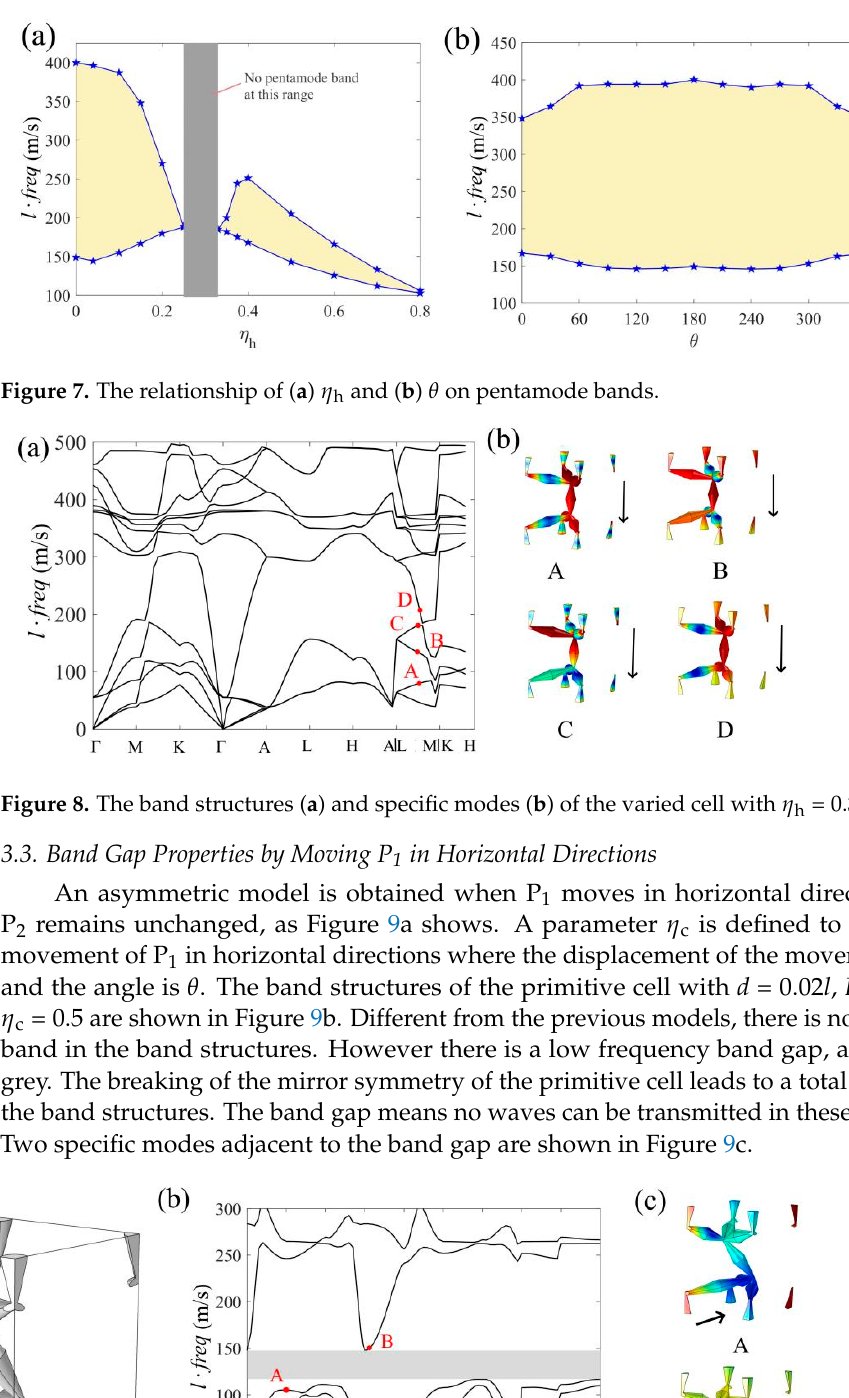
Figure 10. The effects of parameters ( a ) η c ( b ) θ on the band gaps of the primitive cell by moving P 1 in horizontal directions. 3.4. Band Gap Properties by Moving P 1 and P 2 in Opposite Directions Horizontally A band gap is obtained when P 1 moves in the horizontal directions while P 2 remains unchanged. When P 1 and P 2 move in opposite directions horizontally, the primitive cell is also asymmetric, as shown in Figure 11. In this section, the displacements of P 1 and P 2 are the same for simplicity, and noted with η c and θ . Figure 11. The primitive cell with P 1 and P 2 moving in opposite directions horizontally.